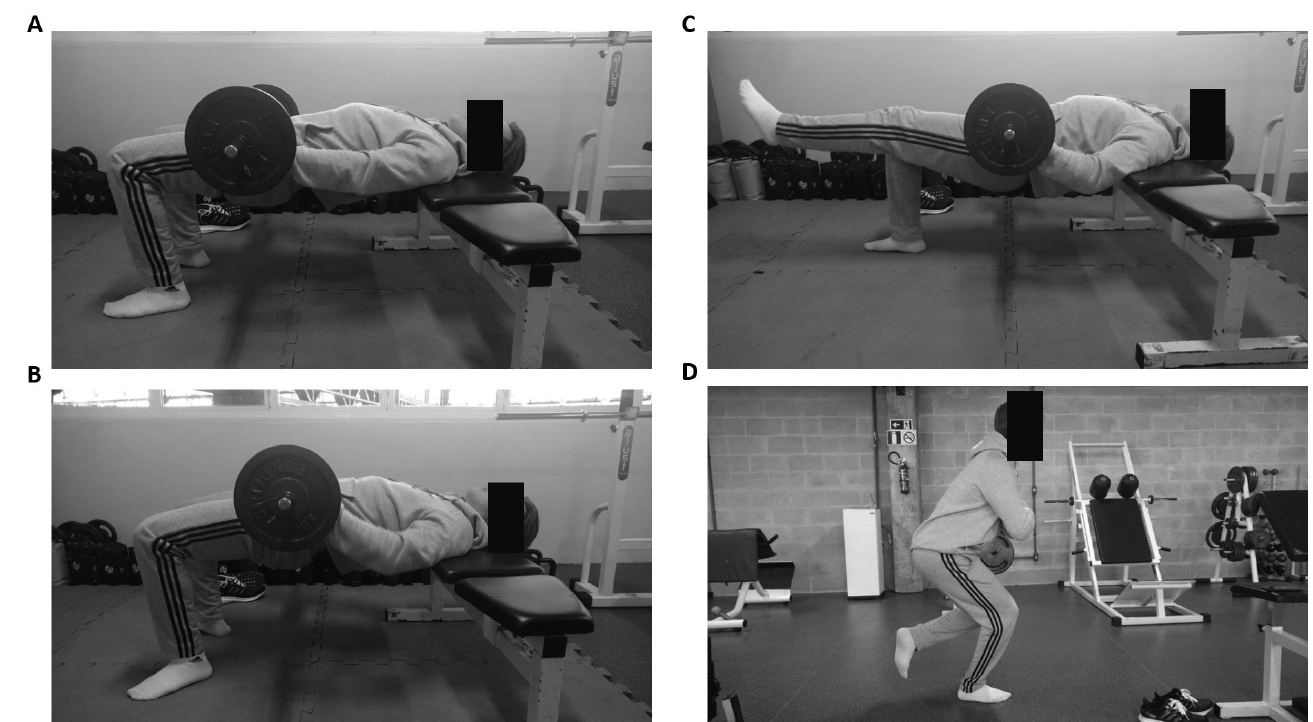
Figure 1. Multi-joint exercises analyzed. Bilateral supine bridge (BiBRG) (A), Bilateral supine bridge with hip abducted (BiBRG-AB) (B), Unilateral supine bridge (UniBRG) (C) and Single-leg Squat (SLS)